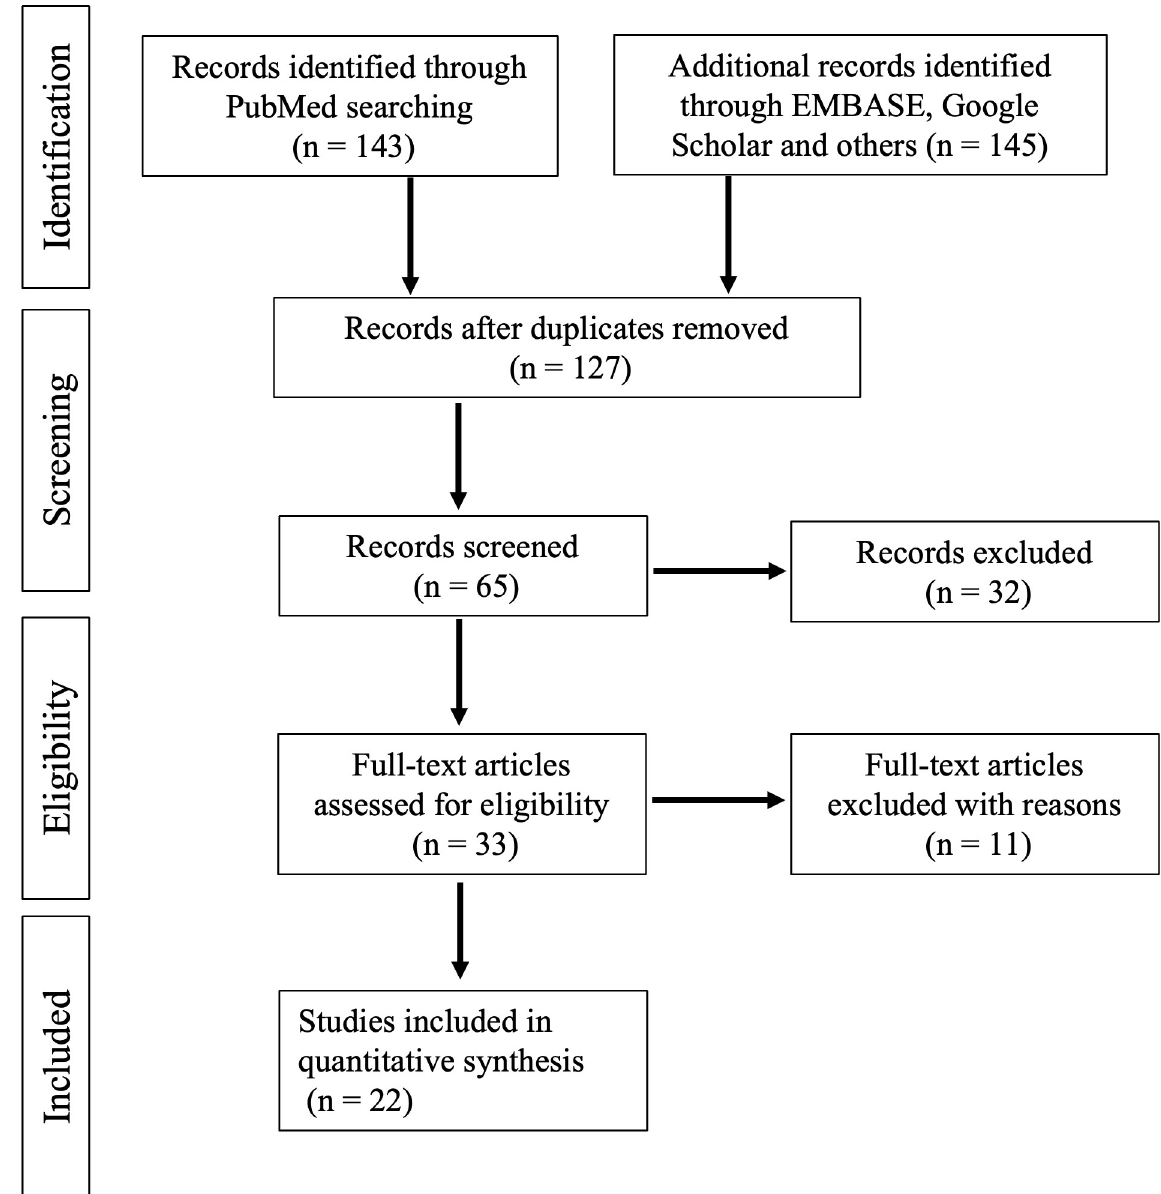
Fig 1. Flowchart illustration of the study